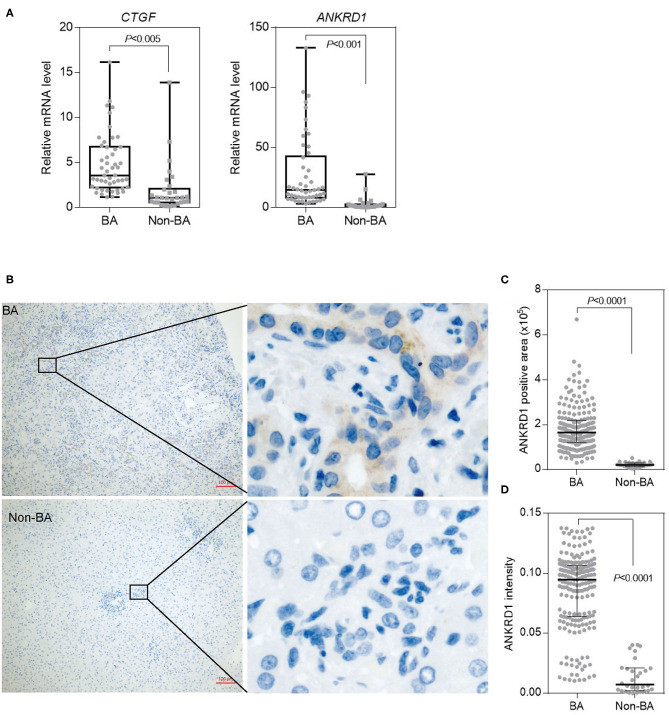
Elevated Expression of ANKRD1 in BA livers. (A) Expression of YAP target genes (CTGF and ANKRD1) in BA (n = 50) and non-BA (n = 30) livers was measured by quantitative PCR. (B) Expression of ANKRD1 protein levels in BA and non-BA livers assessed by IHC. ANKRD1 was mainly localized at cytoplasm of biliary epithelial cells of BA livers. Scale bar: 100 μm. (C) Quantification of ANKRD1 positive area in (B). (D) Quantification of intensity of ANKRD1 IHC signals in (B).